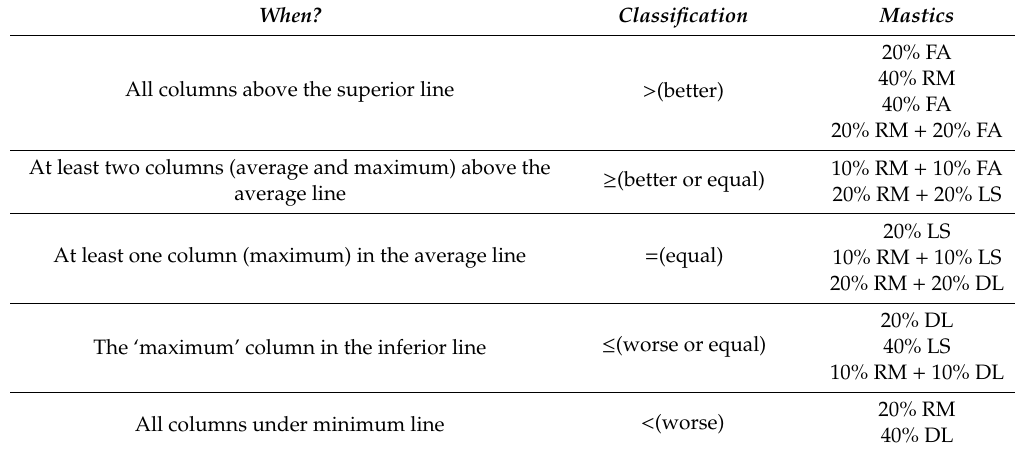
Table 6. Performance rating between mastic and reference sample (without